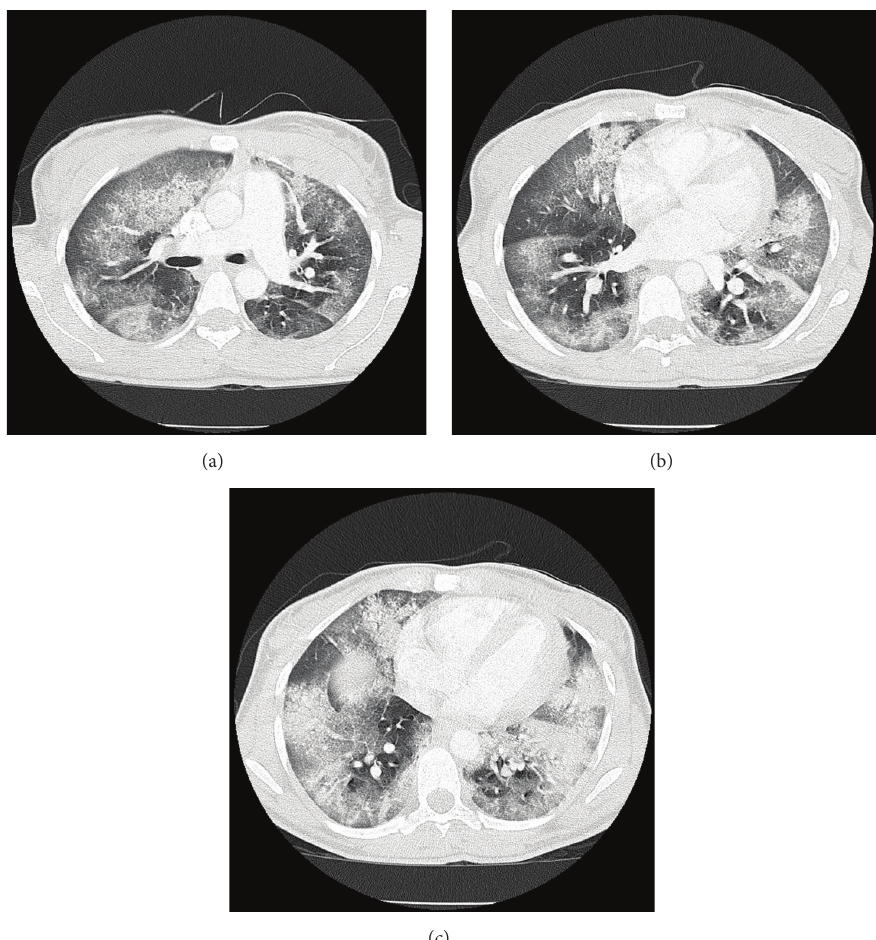
Figure 2: Contrast-enhanced computed tomography demonstrating extensive diffuse ground-glass opacifications, with more confluent opacity involving the lower